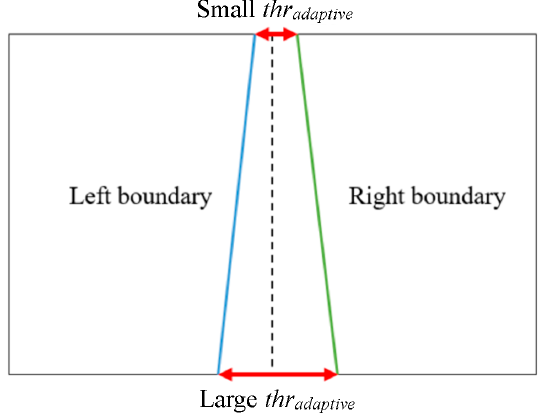
Figure 9. Distance between left and right boundaries of the road lane in the image.